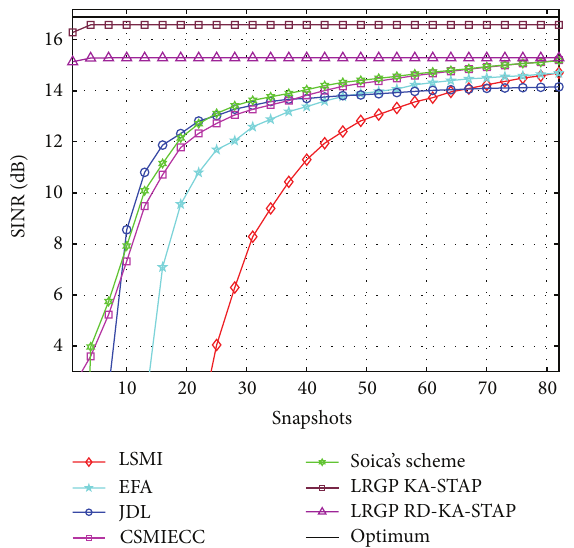
Figure 6: SINR performance against the number of snapshots considering ICM, where 𝜎 V = 0 . 5.